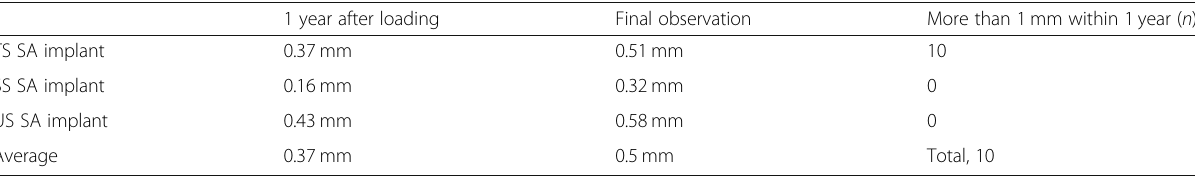
Table 5 Marginal bone loss